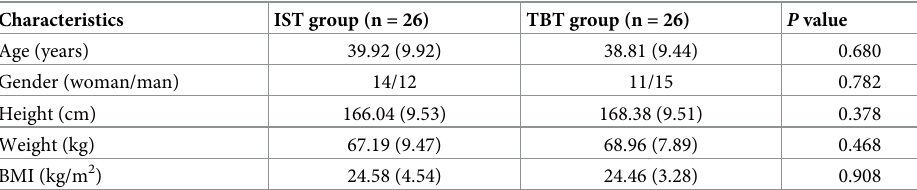
Table 1. Characteristics of the IST and TBT groups.